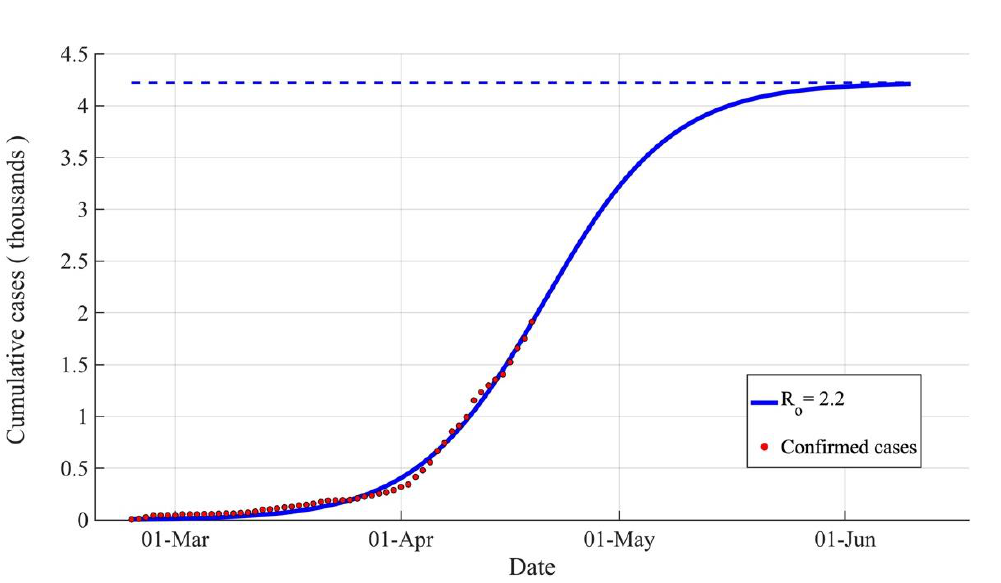
Figure 1. Confirmed and predicted cumulative infections in Kuwait from 24 February to 19 April.